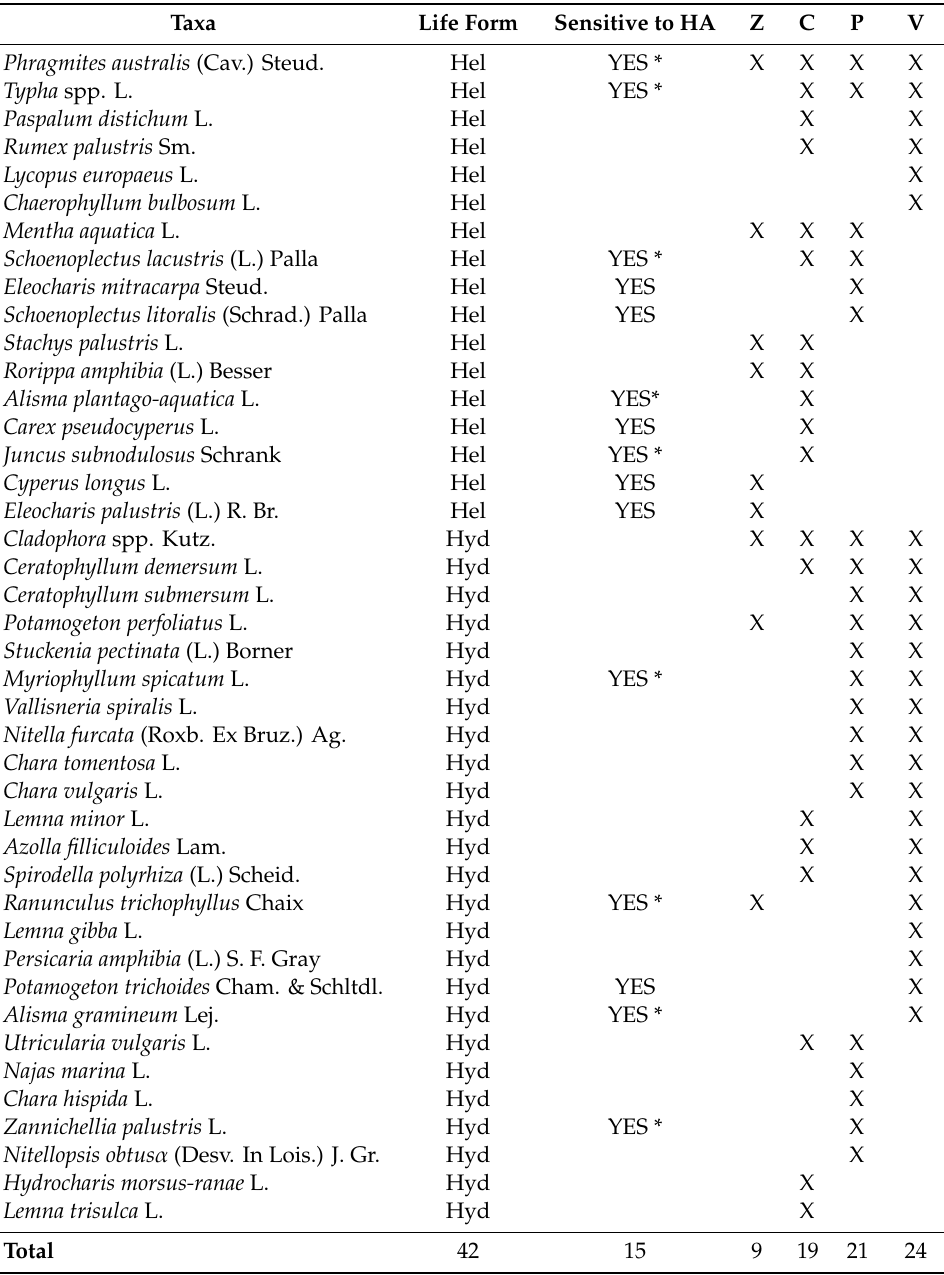
Table3. ListofmacrophytictaxarecordedinlakesZazari(Z),Chimaditida(C),Petron(P),andVegoritida (V) in summer 2016. The taxa sensitive to hydromorphological alterations (HA) are also indicated. Hel—Helophytes; Hyd—Hydrophytes. Taxa Life Form Sensitive to HA Z C P V Phragmites australis (Cav.) Steud. Hel